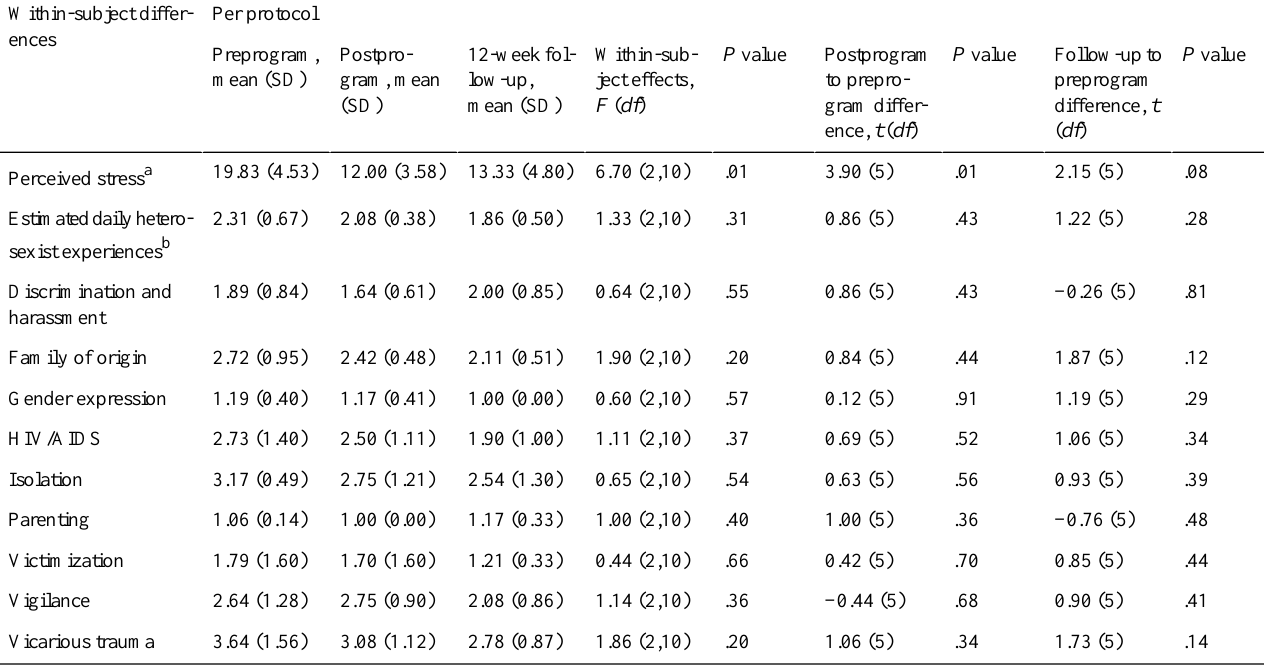
Table 5. Within-subject differences in perceived and minority stress in gay and bisexual men participating in online mindfulness-based stress reduction, by per-protocol